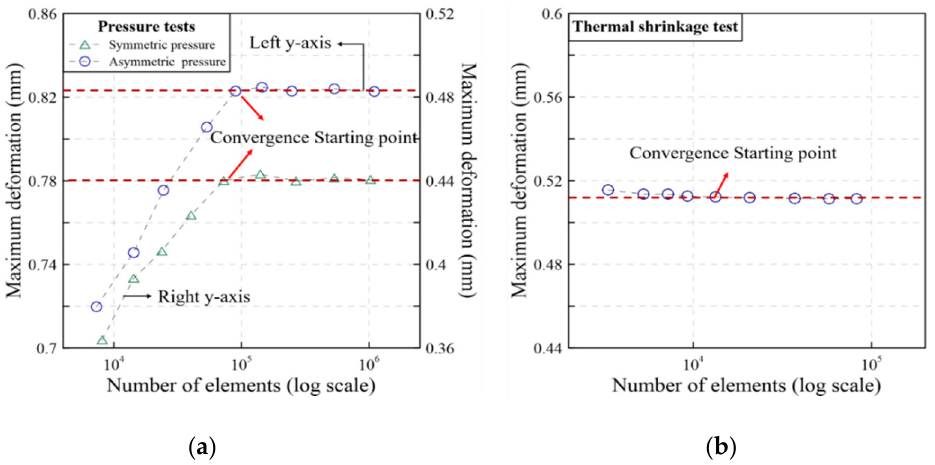
Figure 6. Maximum deformation according to the number of elements in ( a ) pressure tests and ( b ) thermal shrinkage analysis. The red dashed line connotes deformation convergence. thermal shrinkage analysis. The red dashed line connotes deformation